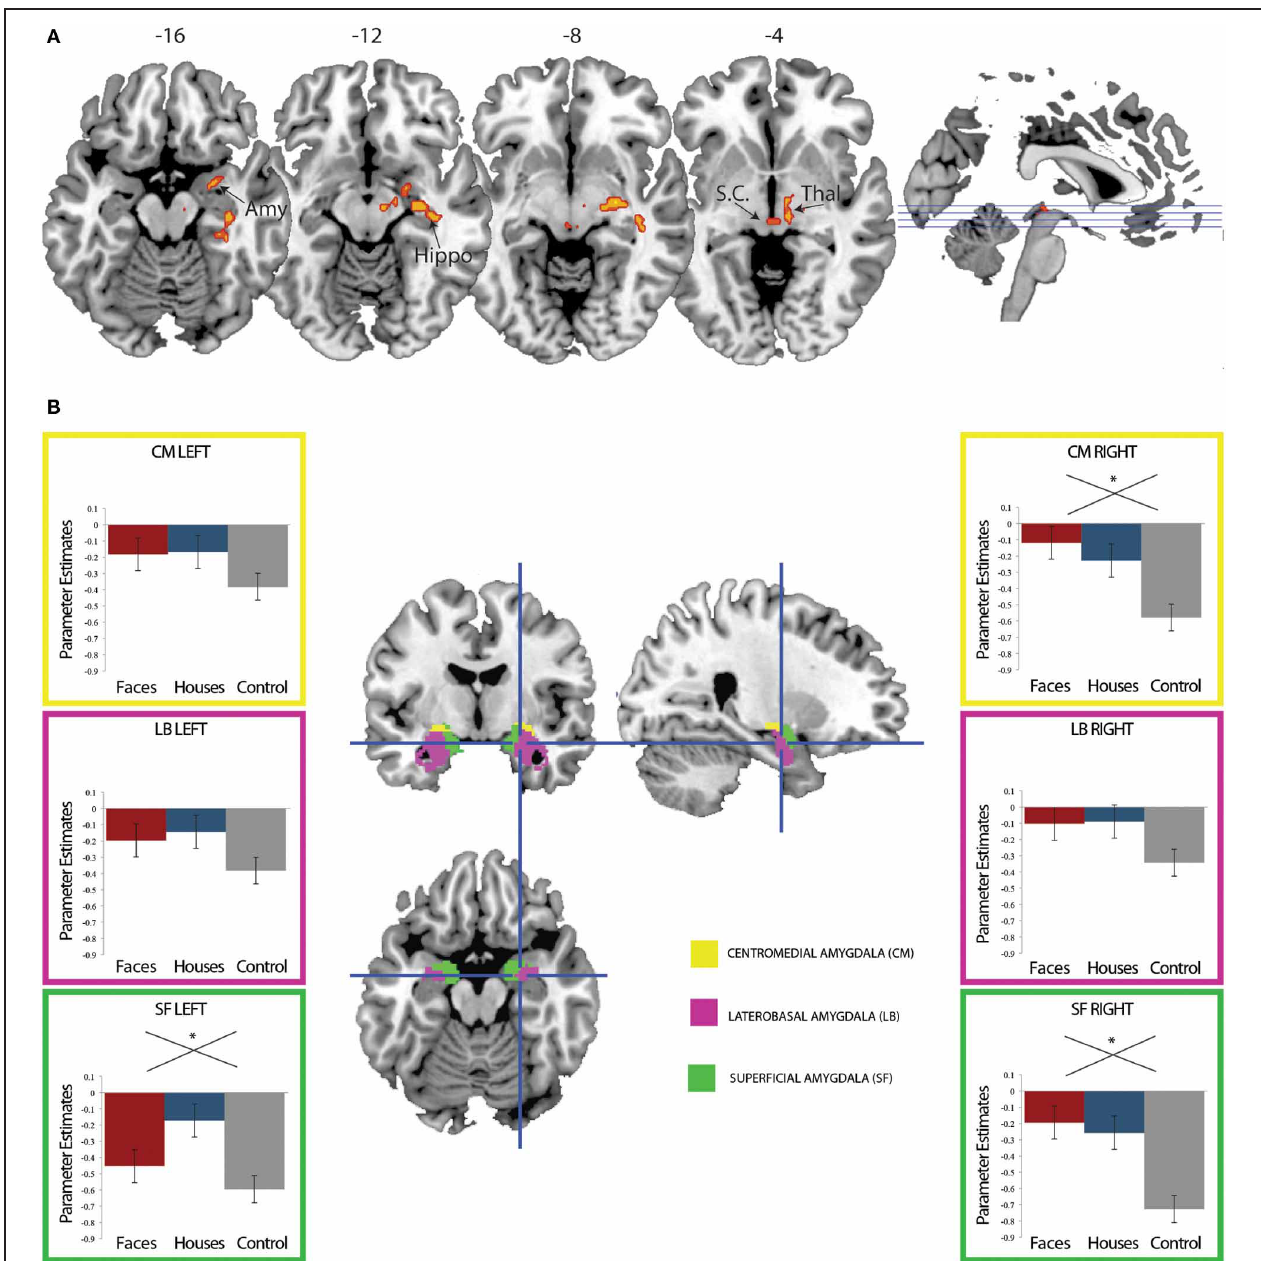
FIGURE 3 | (A) Regions showing greater fMRI response to suppressed fearful facesorsuppressed houses compared tocontrol. Activation tostimulus(fearful faces and houses) compared no stimulus was computed. Suppressed stimuli activated the right amygdala, superior colliculus, thalamus, and hippocampus compared tothe no stimulus control condition (FWE p < 0 . 05 cluster corrected for multiple comparisons). (B) Region of interest analysis using amygdala